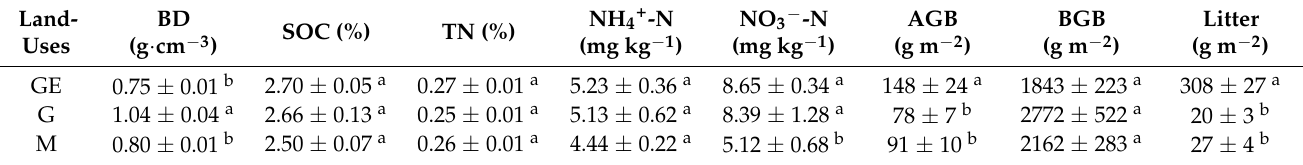
Table 1. Comparison of soil and vegetation properties in the three land-use types. Data are mean ± SE. Sites: grazing-exclusion (GE); grazing (G); mowing (M). BD: bulk density; SOC: soil organic car- bon content; TN: total nitrogen content; NH 4+ -N: soil NH 4+ content; NO 3 − -N: soil NO 3 − content (0–50 cm); AGB: aboveground biomass; BGB: belowground biomass. Different lowercase letters in same column mean significant difference among treatments ( p < 0.05, n =